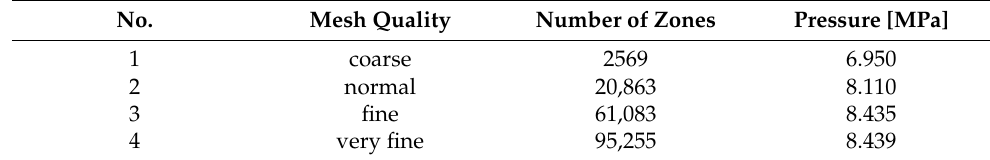
Table 1. Results of numerical grid density study. No. Mesh Quality Number of Zones Pressure [MPa] 1 coarse 2569 fine